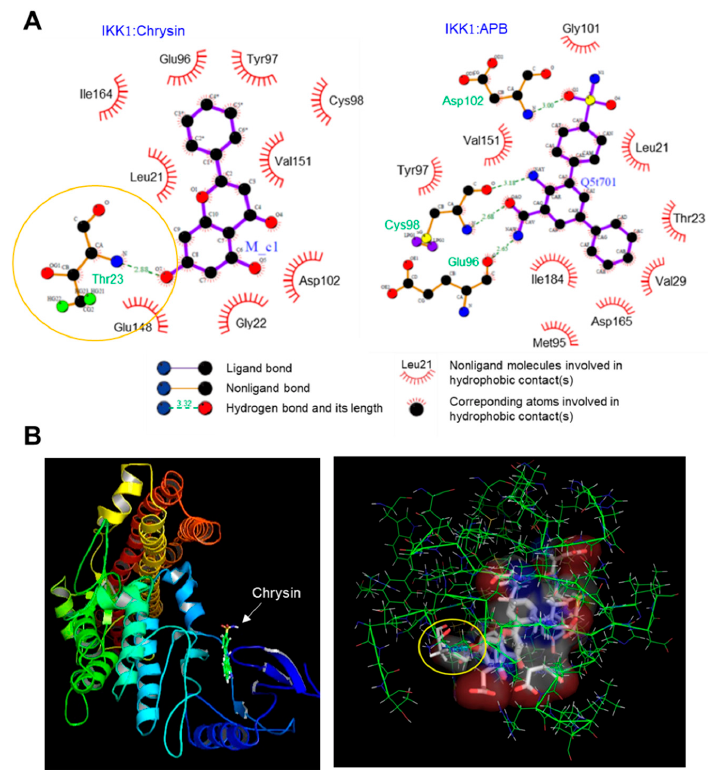
Figure 3. Molecular docking simulation between the inhibitor of κ B kinase 1 (IKK1) and